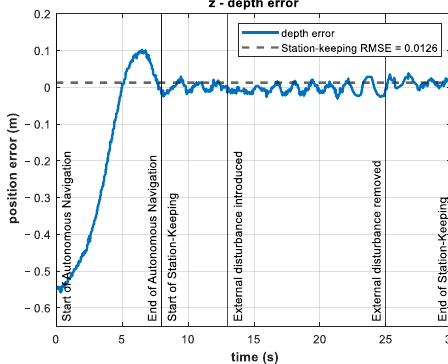
introduced in the interval 13 s ≤ 𝑡 ≤ 25 s . Depth ( left ) and tracking error ( right ).